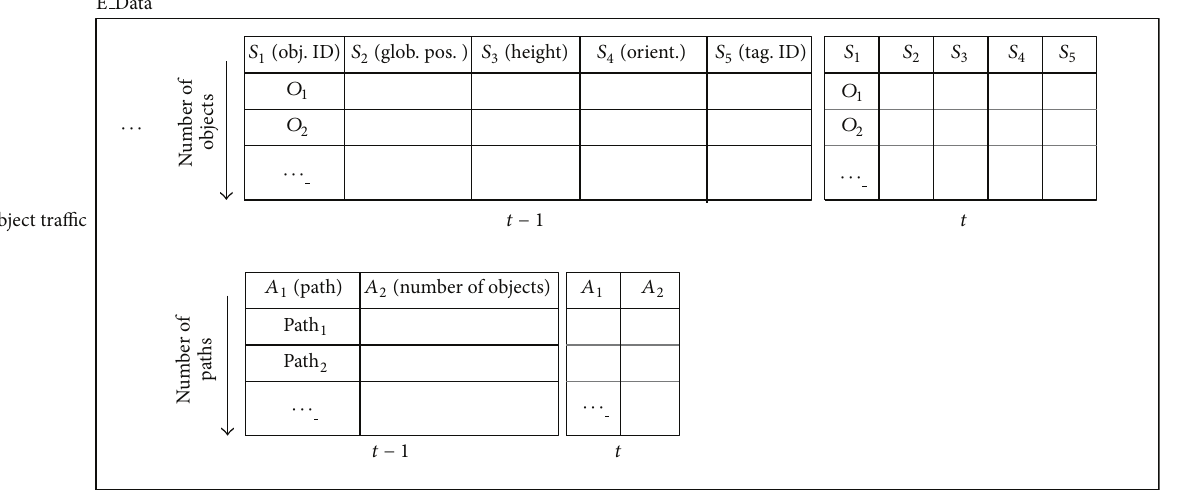
Figure 4: Environment data format for object